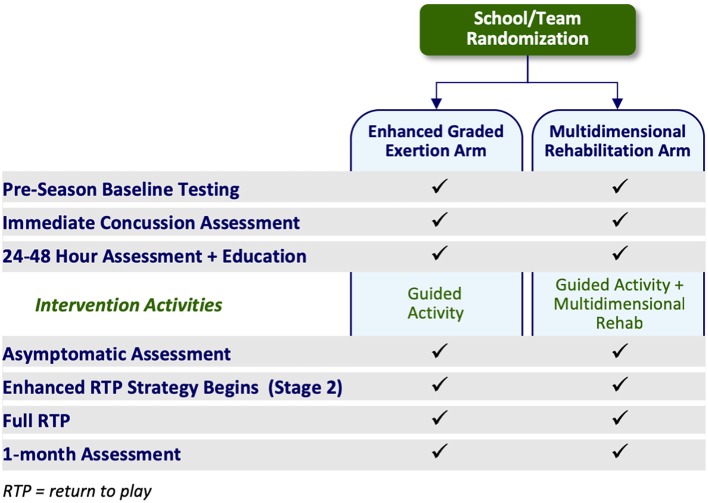
Key study activities by study arm.